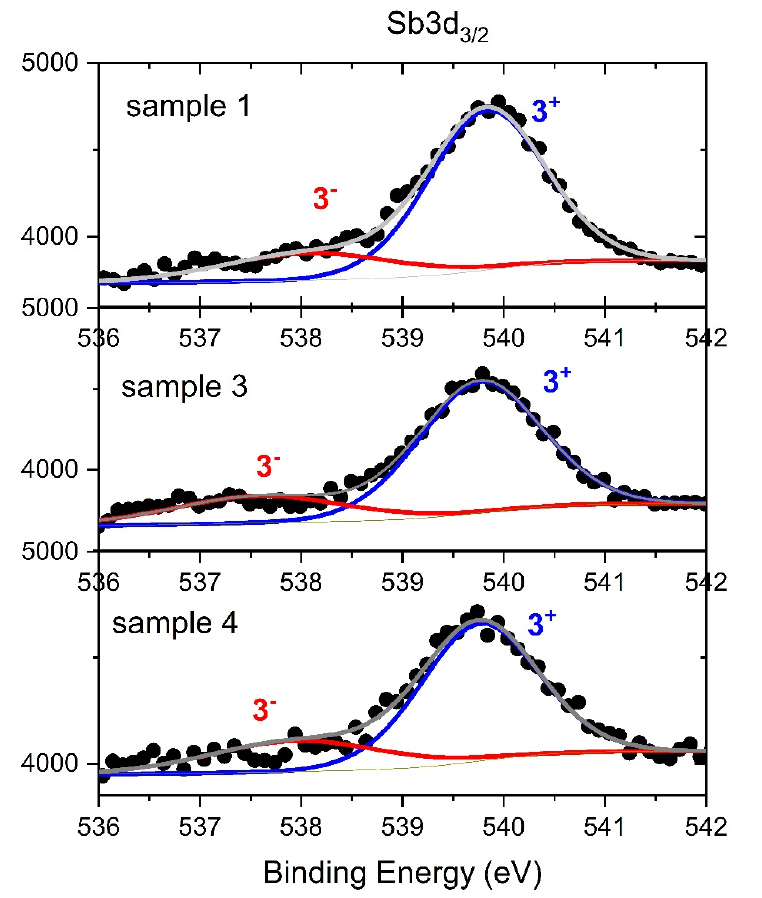
Figure 11. Sb 3d3/2 XPS spectra of ZnO films. Black points ‐ XPS data, solid lines ‐ analysis.